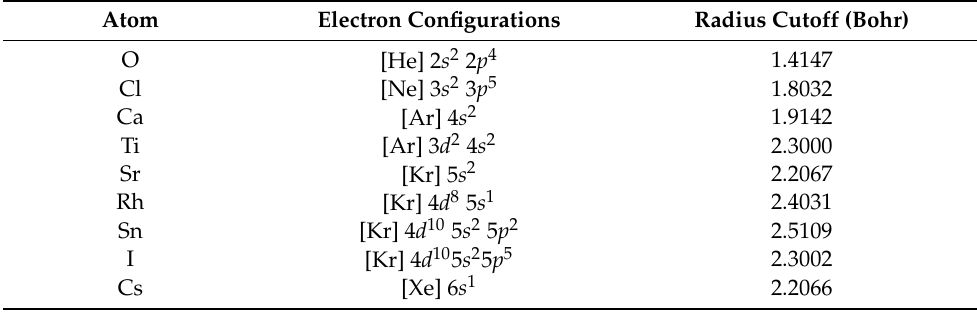
Table 2. Electron configurations and radius cutoff for generate PAW pseudopotentials atom.